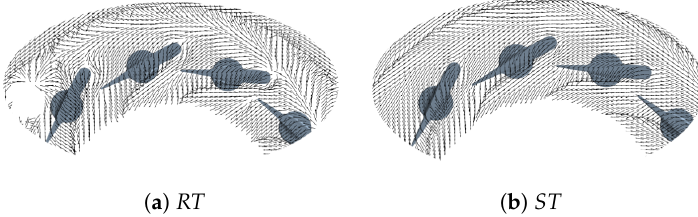
Figure 10. Flow direction over the tip. ST and RT; VGT30; 0.5 mm tip